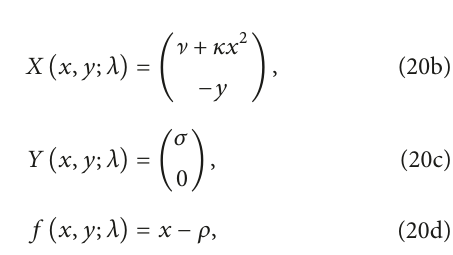
Figure 3: From left to right phase portraits corresponding to the open regions I, II, and III in Figure 2, respectively.